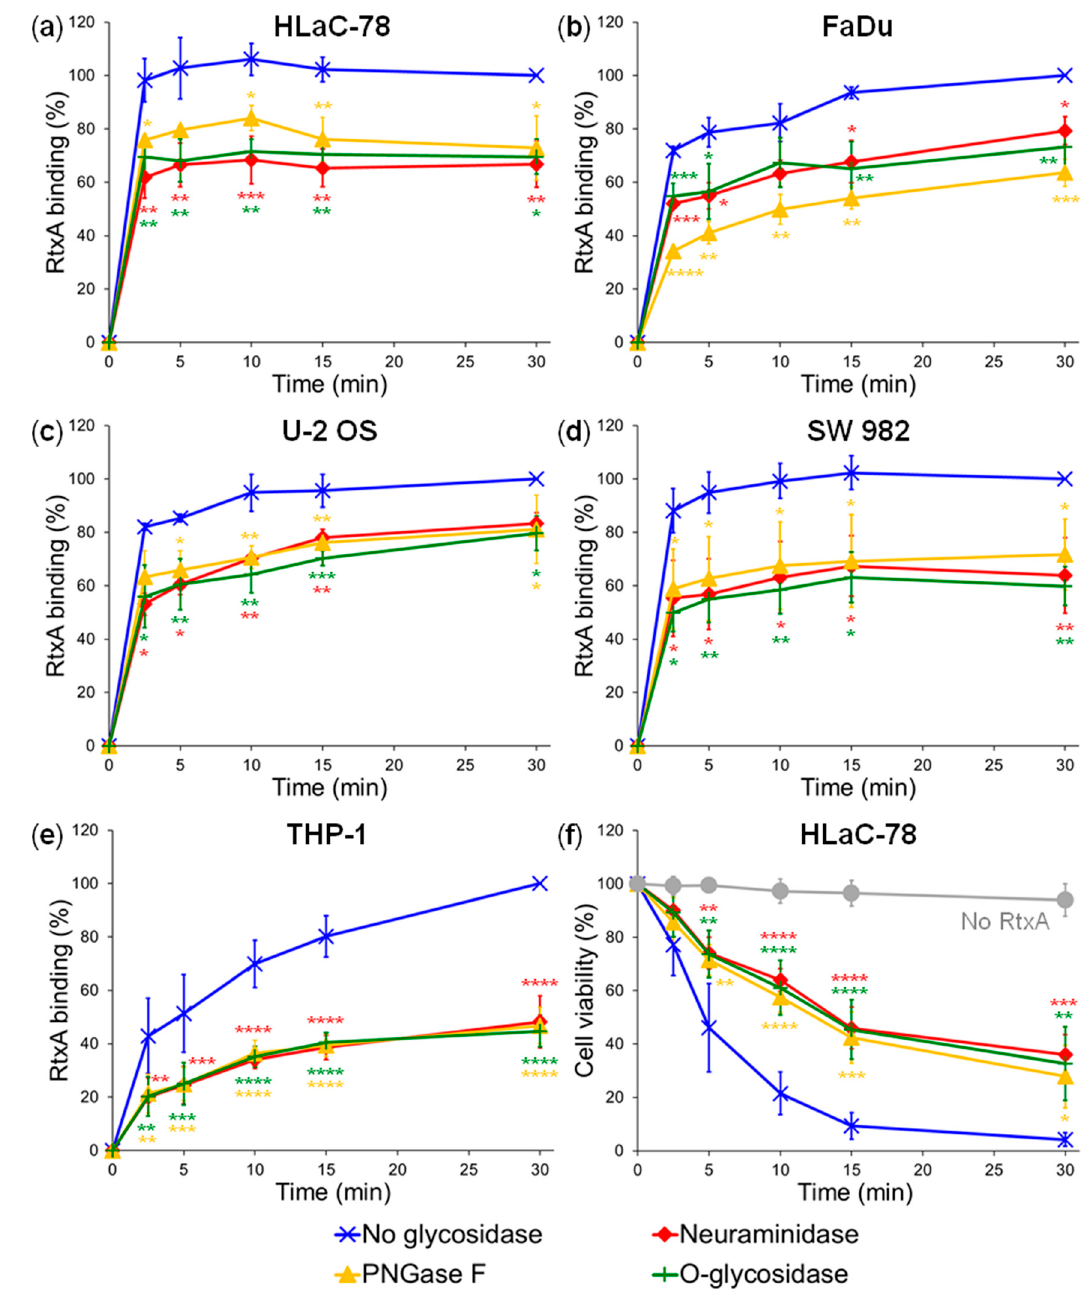
Figure 2. Deglycosylation of cells decreases binding and cytotoxic activity of RtxA. Human HLaC-78 ( a ), FaDu ( b ), U-2 OS ( c ), SW 982 ( d ), and THP-1 ( e ) cells were treated with neuraminidase, PNGase F, O-glycosidase, or bu ff er alone (no glycosidase) for 1 h at 37 ◦ C. Then, the cells (1 × 10 6 / mL) were incubated with 2 µ g / mL of the purified and labeled RtxA-Dy495 toxin for di ff erent times at 4 ◦ C and the surface-bound RtxA-Dy495 was determined by flow cytometry. Binding data were deduced from the MFI values and expressed as percentage of RtxA binding to glycosidase-untreated cells at time 30 min (taken as 100%). Each point represents the mean value ± SD of at least three independent experiments. Significant di ff erences between mean values of RtxA binding to glycosidase-untreated and treated cells are shown (*, p < 0.05; **, p < 0.01; ***, p < 0.001; ****, p < 0.0001; ANOVA). ( f ) Glycosidase-treated and untreated HLaC-78 cells (1 × 10 6 / mL) were incubated with 0.5 µ g / mL of RtxA for di ff erent times at 37 ◦ C. Cell viability was determined by a cell viability staining assay using 1 µ g / mL of Hoechst 33258 followed by flow cytometry. The viability of cells incubated without RtxA (time 0) was reported as 100%. Each point represents the mean value ± SD of five independent experiments. Significant di ff erences between mean values of cell viability of glycosidase-treated and untreated cells upon incubation with RtxA are indicated (*, p < 0.05; **, p < 0.01; ***, p < 0.001; ****, p < 0.0001;